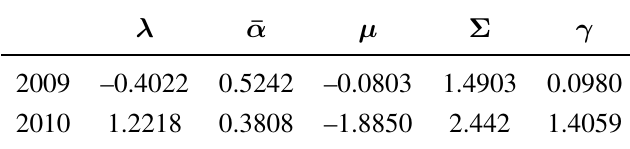
Table 3. Best fit generalized hyperbolic distribution (GHD) parameters for the regression errors of the overconstrained L 2 Markov Tree method applied to the SPX09 and SPX10 data sets. For further discussion of the results of this table and Figure 2, see Section